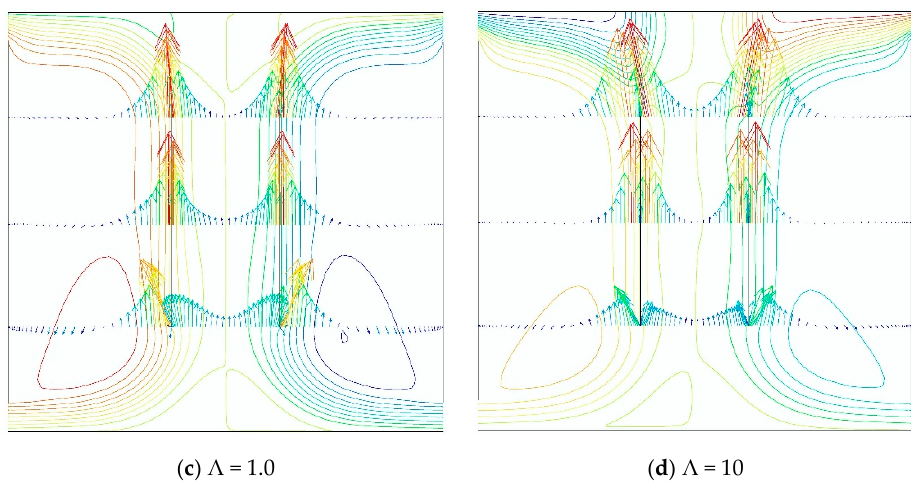
Figure 11. Total streamlines and vector profiles through the channel for Ra H = 10 9 , b / H = 0.5, and different values of heating parameter Λ . Configuration is given in Figure 1b. Maximum values of ψ = VH / ν Gr H are equal to 4.90 × 10 − 5 , 2.01 × 10 − 5 , 1.06 × 10 − 5 , and 7.85 × 10 − 6 , respectively, for cases a, b, c, and d.